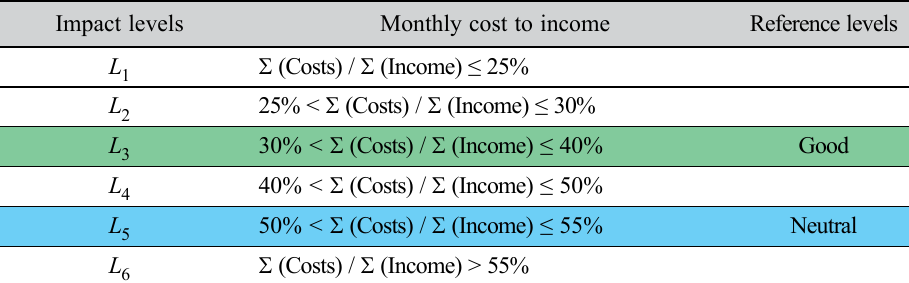
( Cost to Income 2